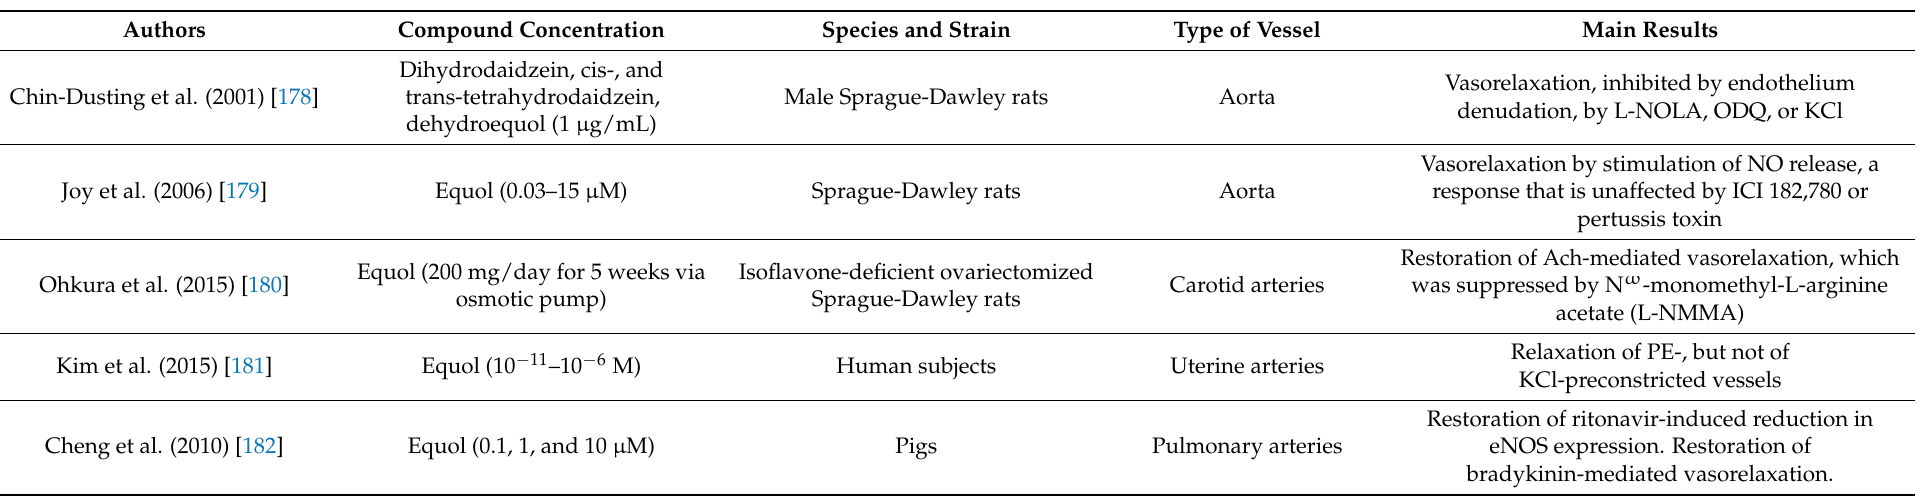
Table 6. Description and main results of in vitro studies on the vasorelaxant activity of equol and other